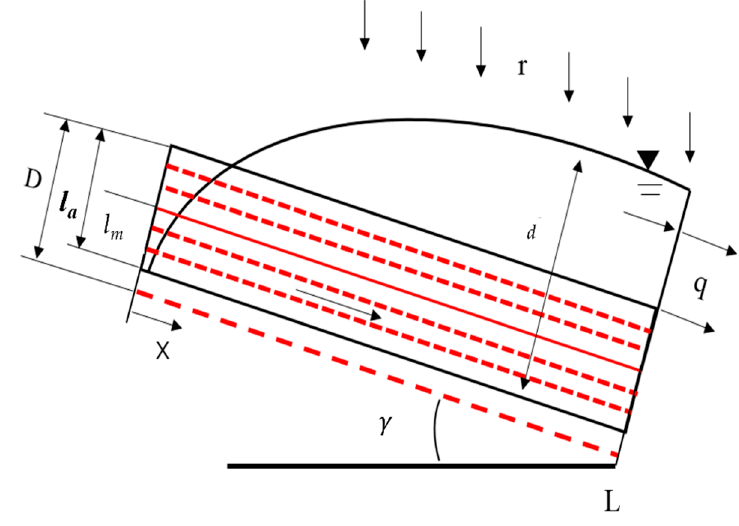
6 of 23 Figure 3. MCDRM model structure and schematic diagram. The Basin terrain data of the MCDRM model was represented by the digital elevation